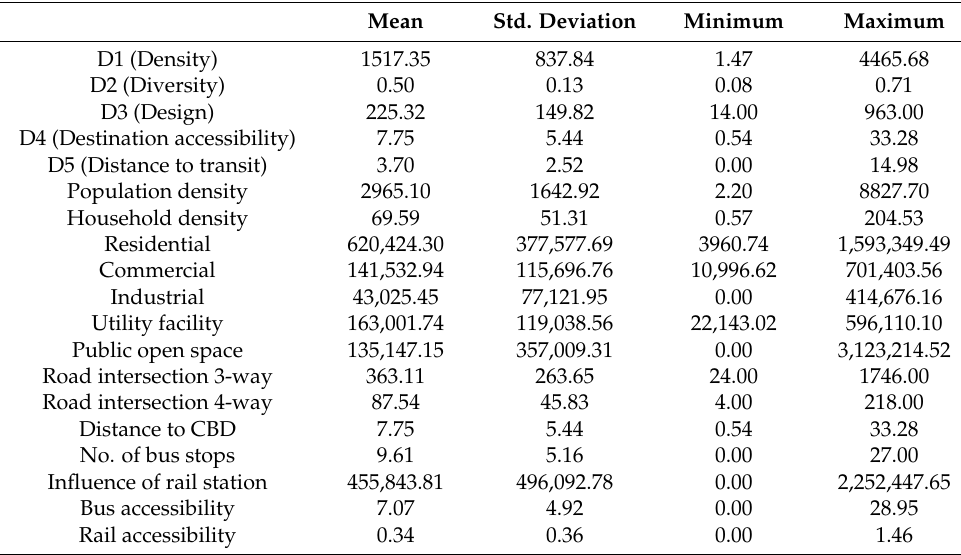
Table 1. Descriptive result summary—urban form